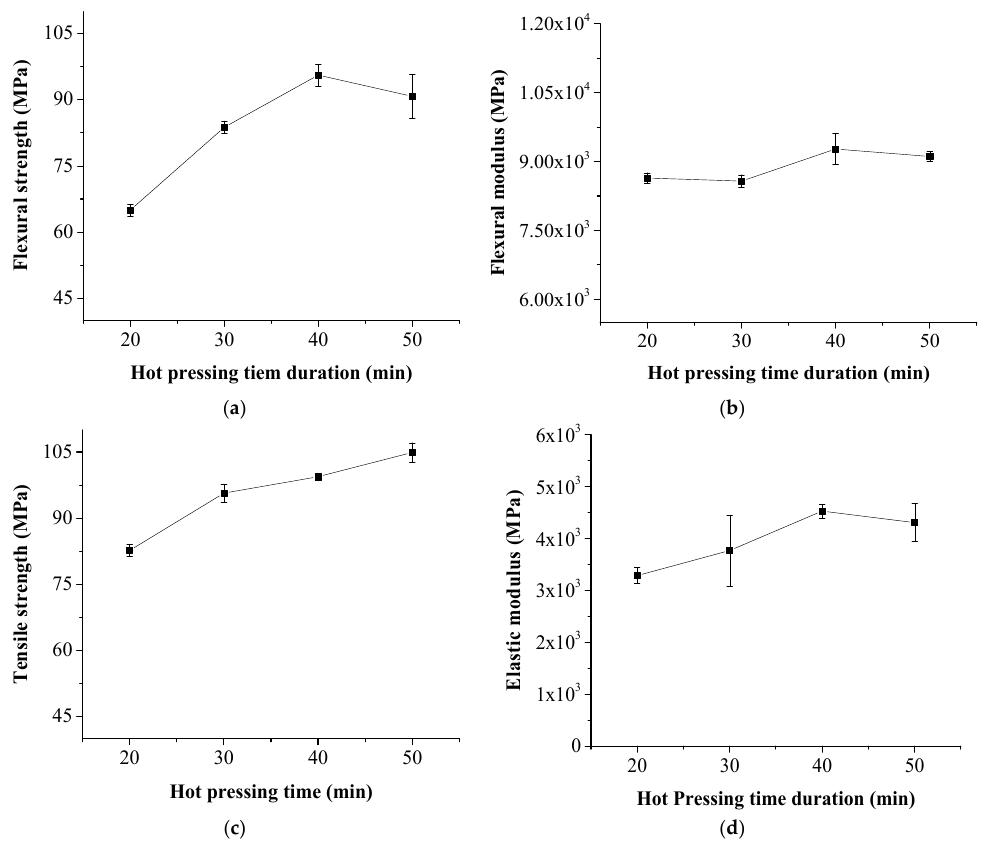
Figure 2. Effects of the hot pressing time duration on mechanical properties of the composite. ( a ) flexural strength; ( b ) flexural modulus; ( c ) tensile strength; ( d ) elastic modulus. Effects of the hot pressing time duration on the water absorption behavior of the laminated composites are shown in Figure 3. The 24-h water absorption and the thickness expansion of the composite decreased from 37.9% to 8.7% and 25.0% to 1.1% with the increase of the hot pressing time duration from 20 min to 40 min. Pores and voids in the NP layers provided a pathway for water transmission due to the capillary effect. The pathway was partially blocked with the permeation of the melted HDPE into NP layers during hot pressing procedure. The 24-h water absorption and the thickness expansion rebounded slightly when the hot-pressing time exceeded 40 min.